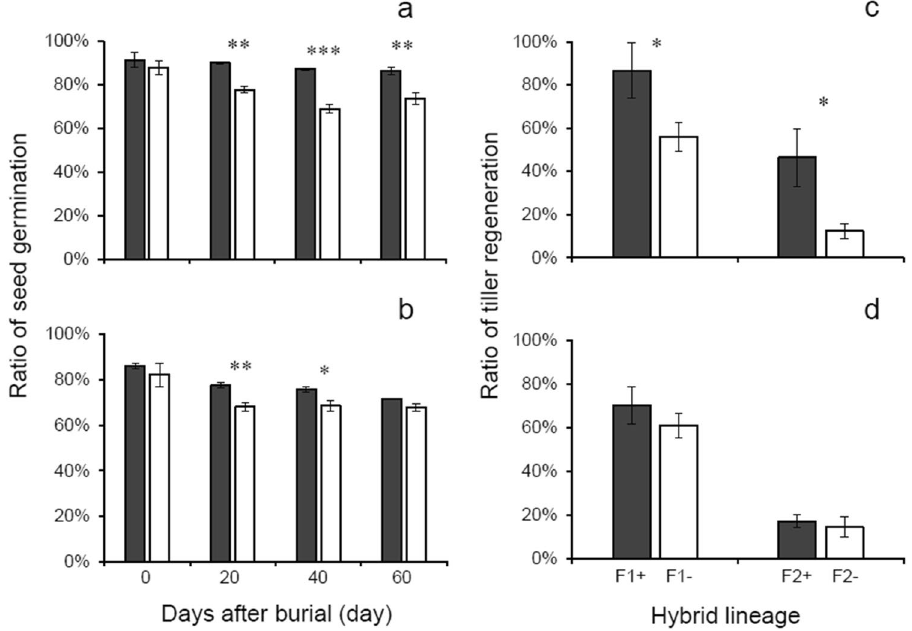
Figure 4. Germination ratios of buried-seeds ( a : WR1-F3, b : WR2-F3) and ratios of tiller regeneration ( c : WR1-F1 and WR1-F2, d : WR2-F1 and WR2-F2) in transgenic (dark grey columns) and non-transgenic (white columns) crop-wild hybrid lineages. The comparisons were made between transgenic and non-transgenic hybrid lineages based on independent t -test (N = 3 for seed germination ratio; N = 6 for tiller regeneration ratio). Bars represent standard error. * or ** indicates significances at the levels of P < 0.05 or P < 0.01,